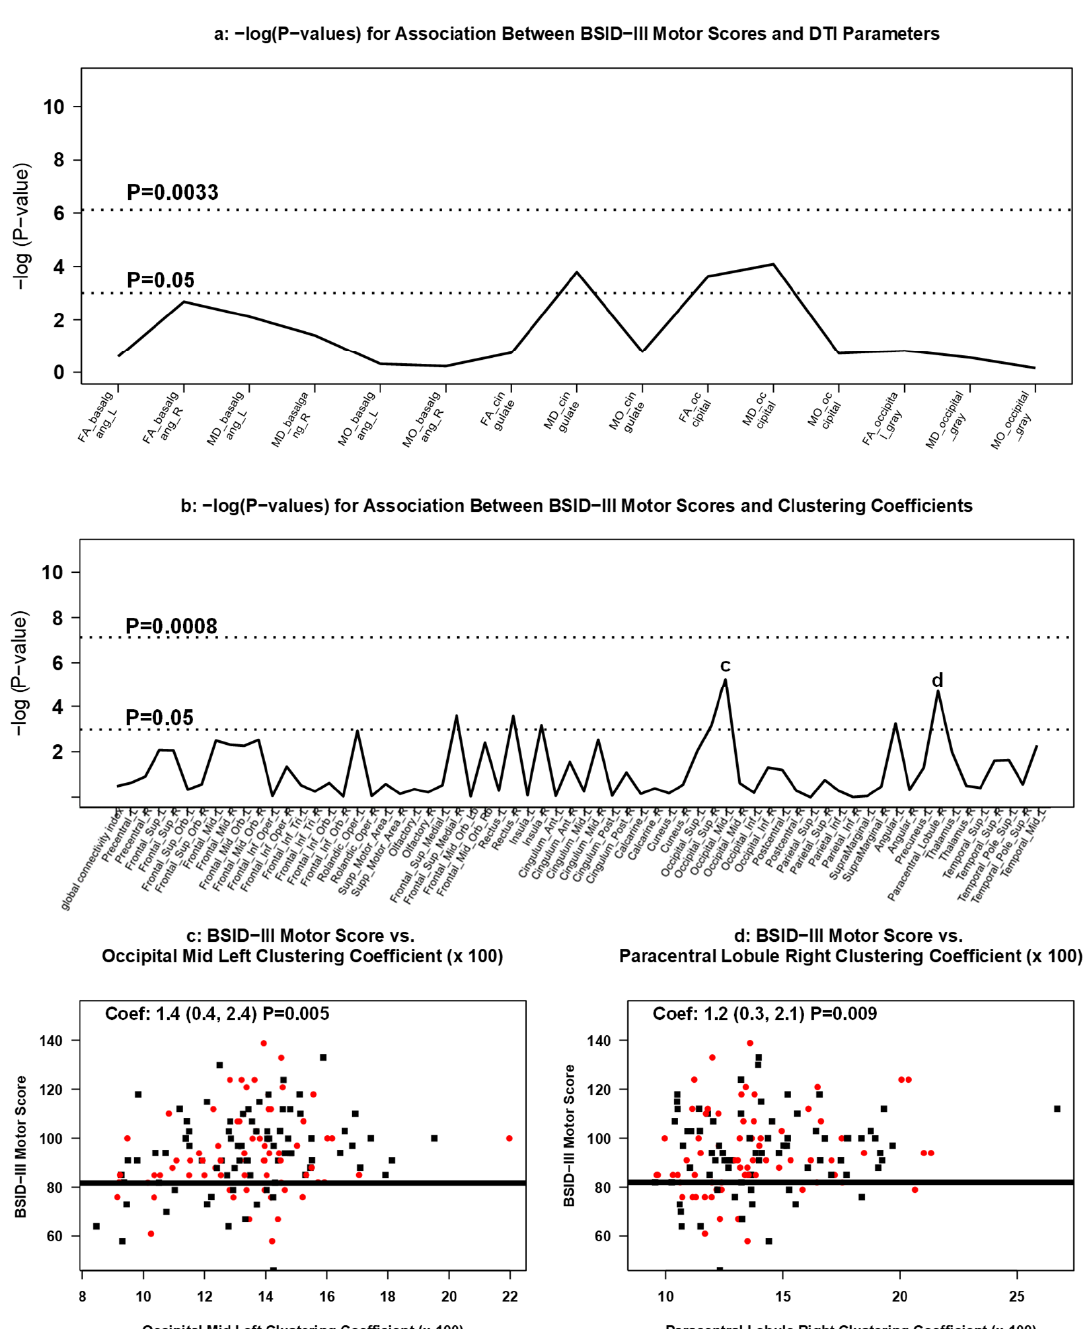
Figure 6. Association between DTI measures and BSID-III motor scores. Manhattan plots of [GEE-based Wald test] -log ( p -values) for differences in ( a ) regional DTI diffusion values and ( b ) clustering coefficients by BSID-III motor scores. Panels ( c , d ) display scatterplots of BSID-III motor scores and statistically significant GEE-based associations with clustering coefficients. Red dots represent infants treated with Epo; black squares represent infants treated with placebo.